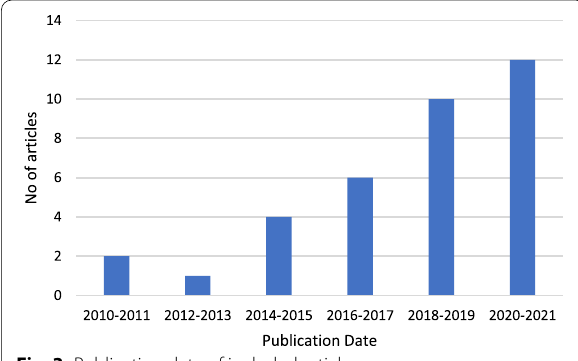
Fig. 2 Subject area focus of publishing journals